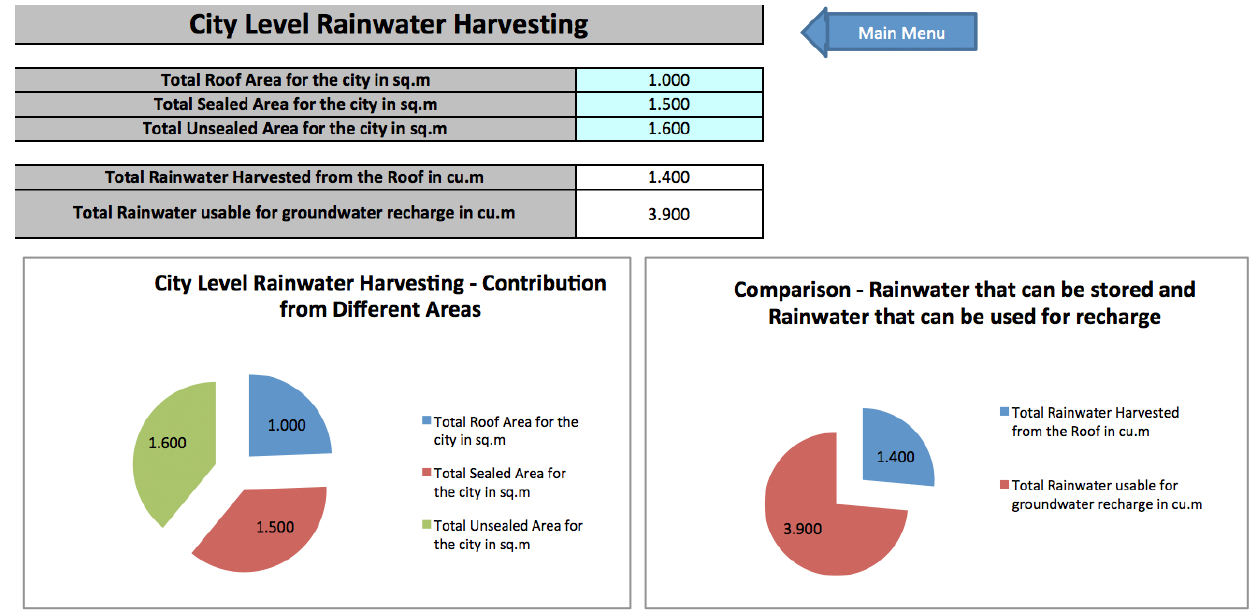
Figure 11. “City Level rainwater harvesting (RWH)” sheet in “Wise Water”. The user can enter the size of different area types in the blue marked cells. Diagrams illustrate the contribution of different areas to the rainwater harvesting as well as the amounts of rainwater that can be used for storage and